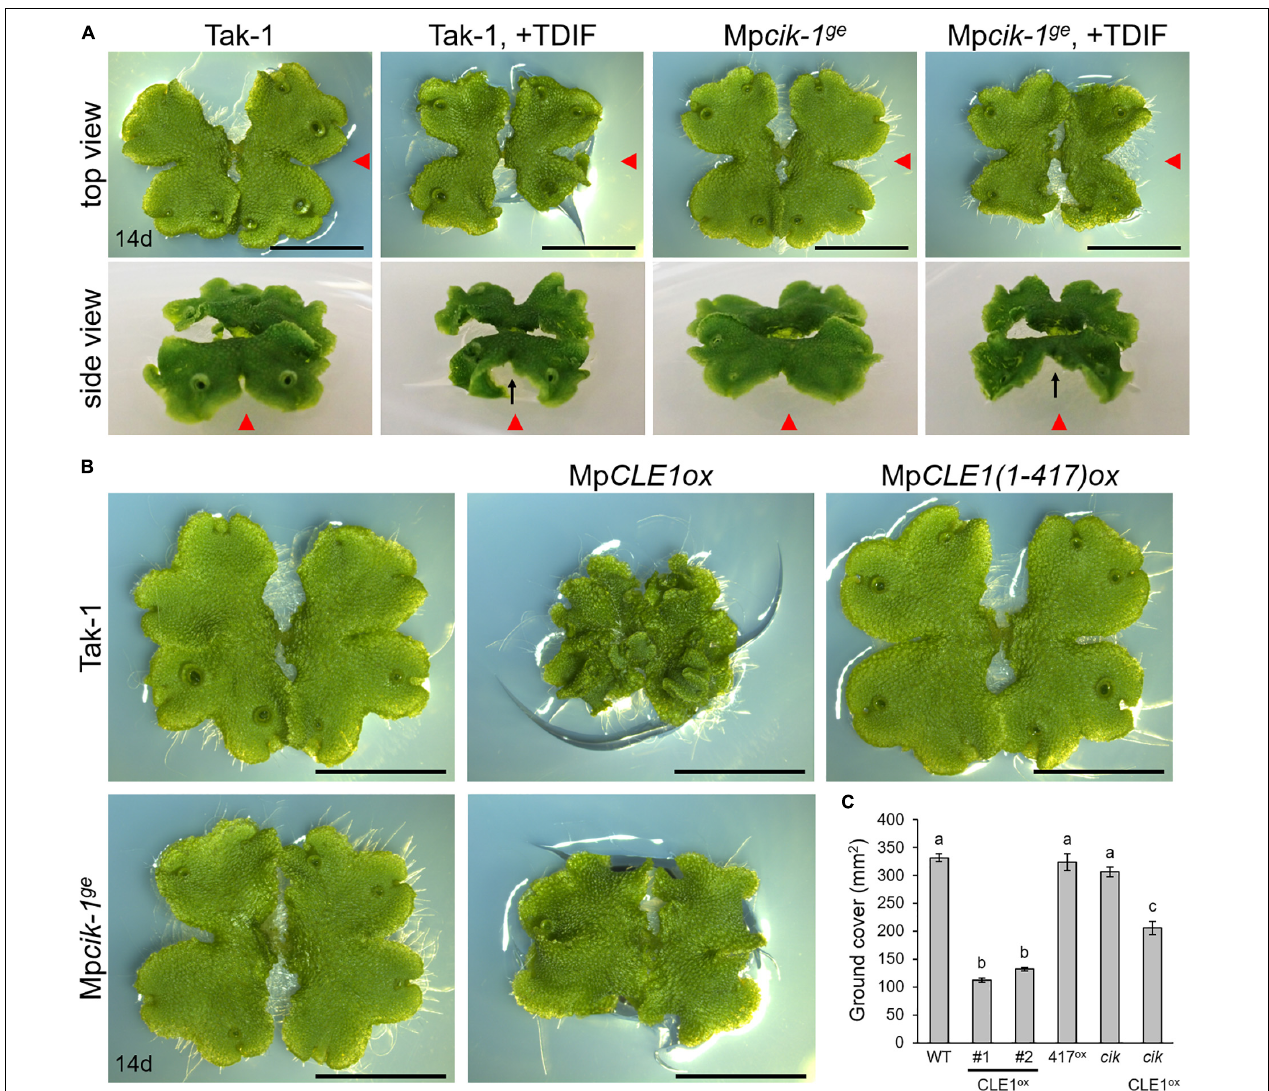
FIGURE 5 | Growth of Mp cik thalli is sensitive to MpCLE1/TDIF activity. (A) Overall morphology of 14-day-old plants grown from gemmae on medium supplemented with or without TDIF peptide as indicated above. Side view panels show the images taken from the right in the top view panels as indicated by red arrowheads. Note that thalli are twisted in plants treated with TDIF, resulting in the uplift of the thalli from the medium as indicated by arrows. (B) Overall morphology of 14-day-old plants grown from gemmae. MpCLE1 ox indicates overexpression under Mp YUC2 promoter ( pro Mp YUC2 :Mp CLE1 ) in Tak-1 and Mp cik-1 ge background. Mp CLE1(1-417)ox , indicates a truncate version of Mp CLE1 . (C) Ground cover in 14-day-old plants (mean and SD; n = 11–14). Means sharing the superscripts are not significantly different from each other in Tukey’s HSD test, p < 0.05. Scale bars represent 1 cm in panels (A) and (B)